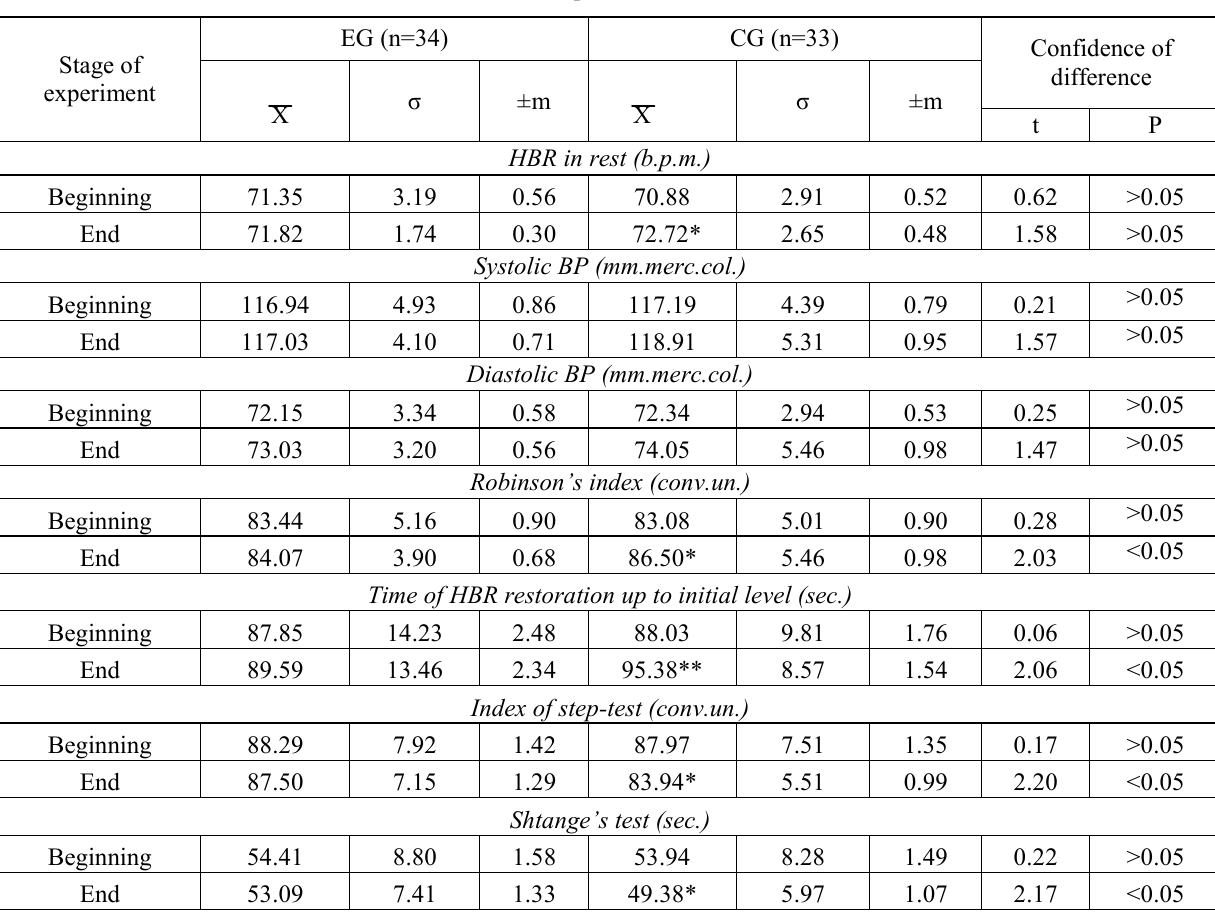
indicators of CG peace makers